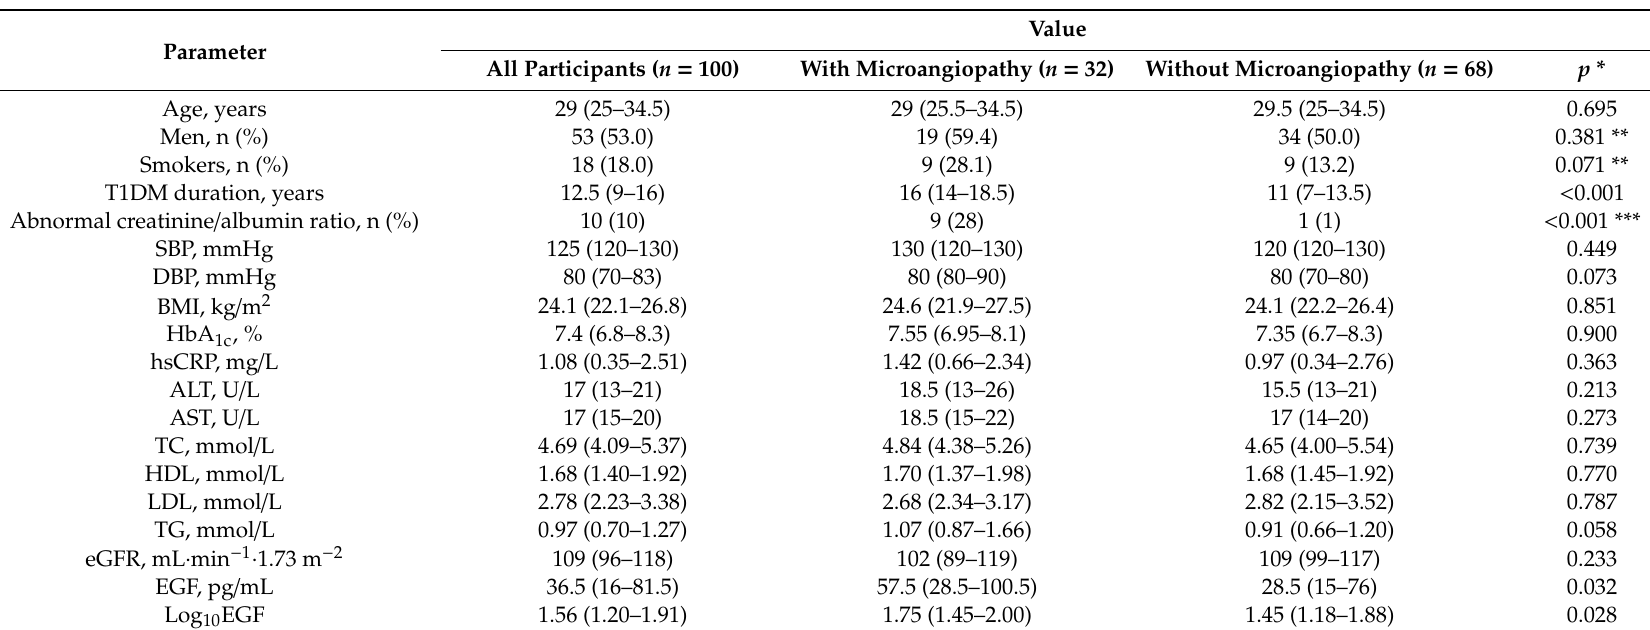
Table 2. Characteristics of the study participants according to the presence of microangiopathy in the EGF cohort (number or median (IQR)).